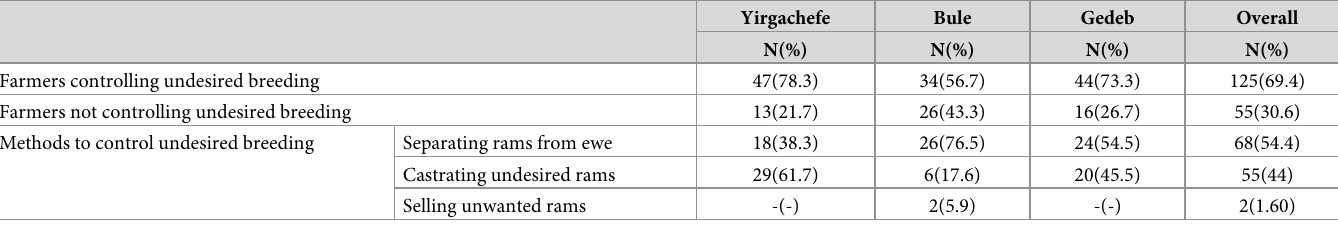
Table 4. Methods to control undesired sheep breeding in Gedeo zone.